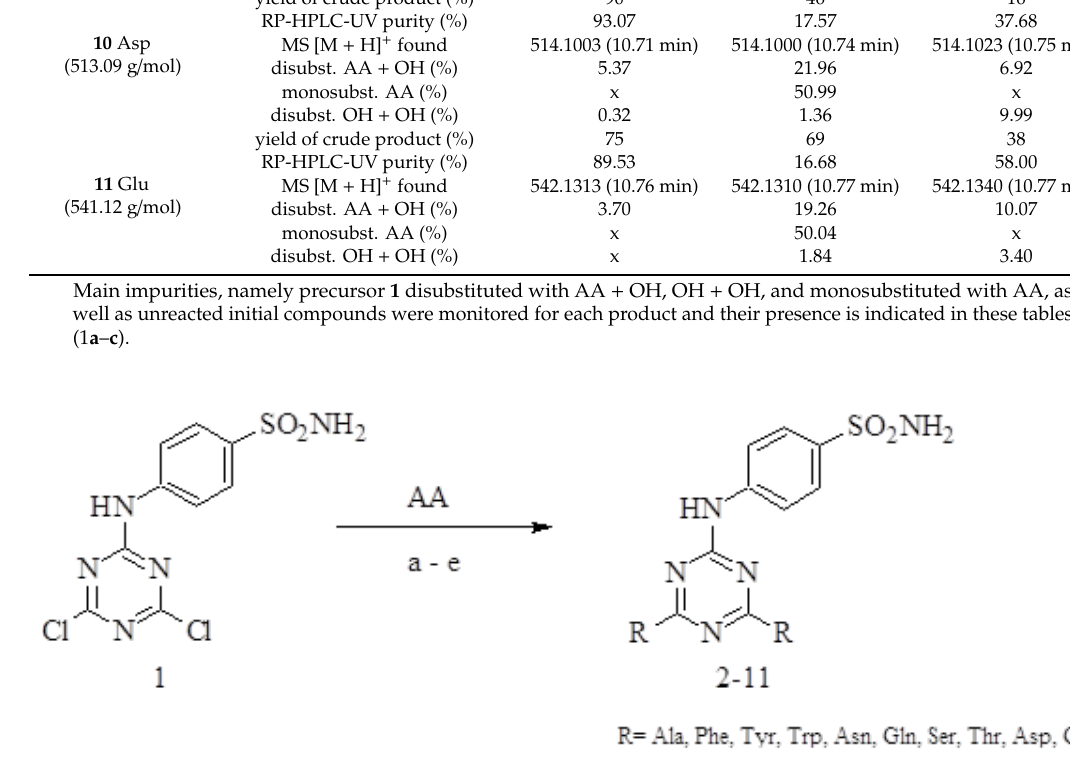
Figure 1 . Synthesis of triazinyl-substituted benzenesulfonamide derivatives ( 2–11 ) using various reaction conditions: ( a ) Na 2 CO 3 in water, 100 °C; ( b ) NaHCO 3 in water, 100 °C; ( c ) 0.2% triethylamine (TEA) in water or